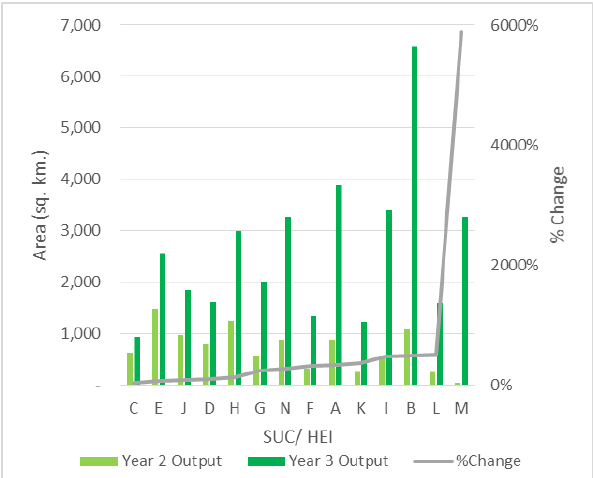
Figure 16. Project Accomplishments and Remaining Target Areas